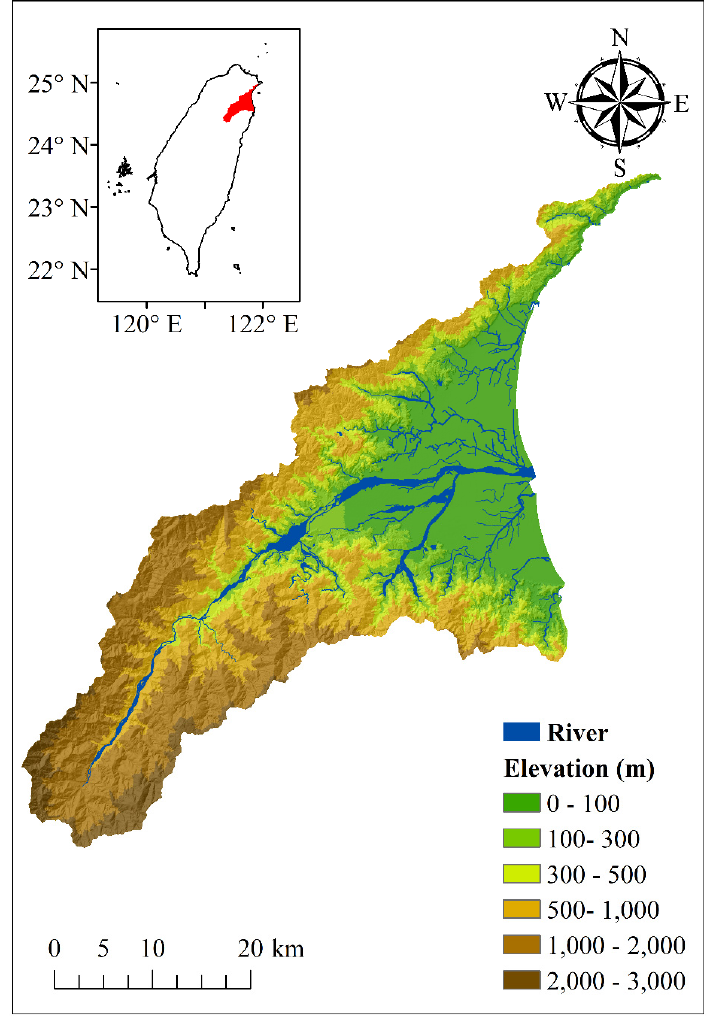
Figure 1. Study Figure 1. Study area.